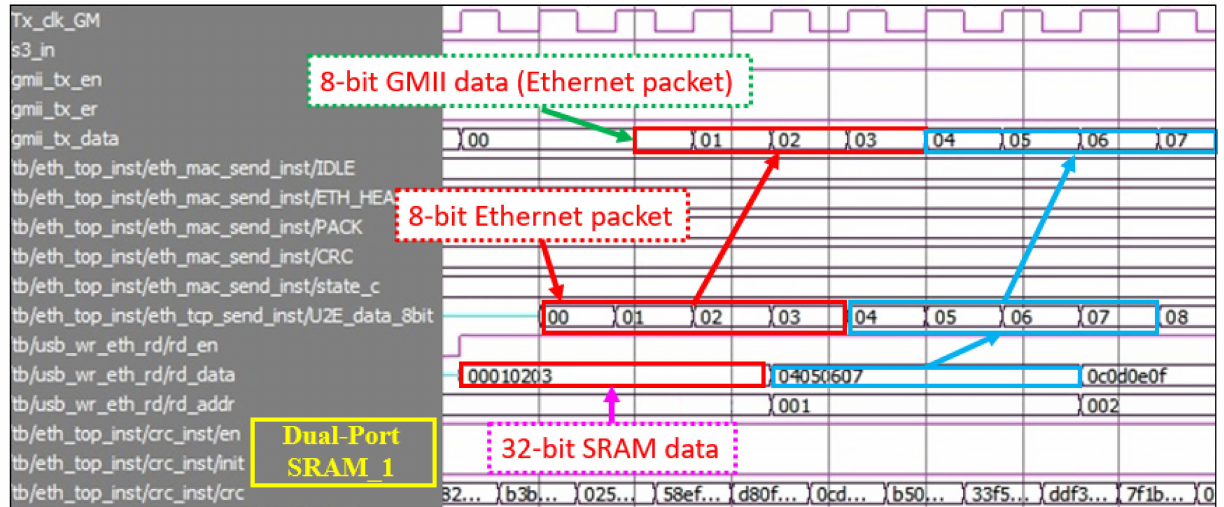
Figure 14. The transmission from SRAM (USB data) to GMII interface (Ethernet packet).